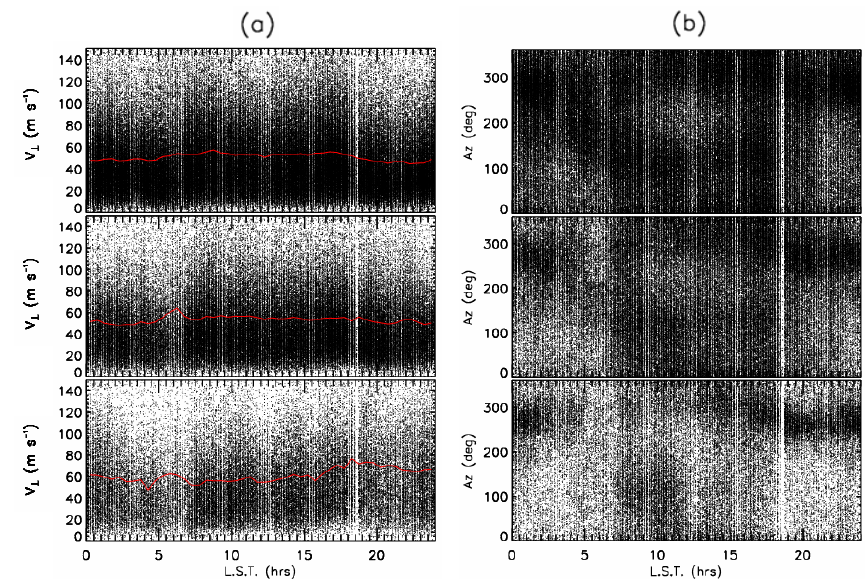
Fig. 2. Mass plot of (a) all drift velocity magnitudes perpendicular to the magnetic field, V ⊥ , and (b) drift directions perpendicular to the geomagnetic field, A z , for geomagnetically quiet conditions AE < 75nT (top); disturbed conditions 200nT < AE < 300nT (middle), and very disturbed conditions (AE > 500nT) (bottom). The red curves show the 10-min running averages of V ⊥ . The vertical white stripe at ∼ 18:52LST is due to daily internal calibrations used to correct any phase differences between the four receiver cards of the DPS-4. Local solar time (LST) corresponds to UT+09:40h at Bundoora.